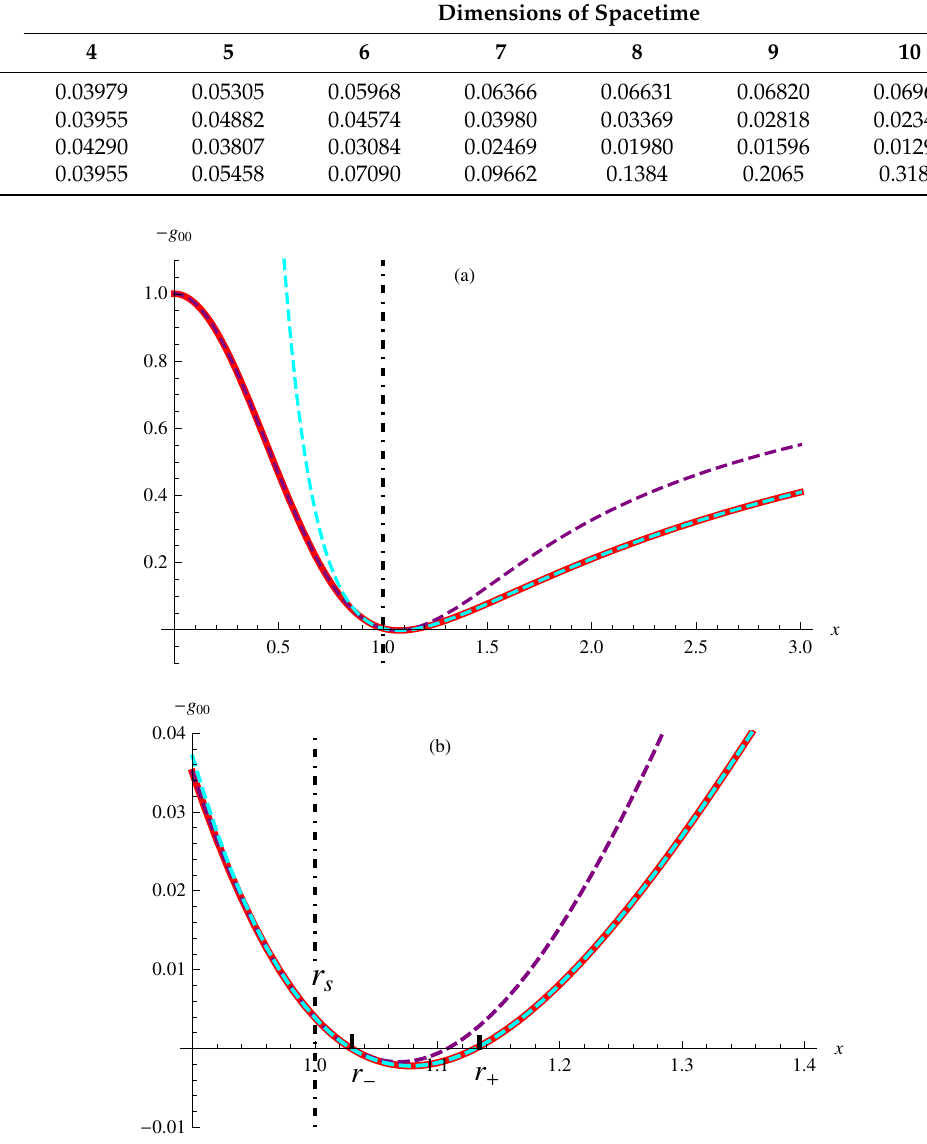
Figure 2. An example of β ≤ β 1 and β 2 < β < β 3 : n = 4, β = 0.0397, where ( b ) is the magnified image of ( a ) within the range x ∈ [ 0.9,1.3 ] . This case is characterized by r s < r − and f ( x ) > 0 for x ∈ [ 0,1 ]